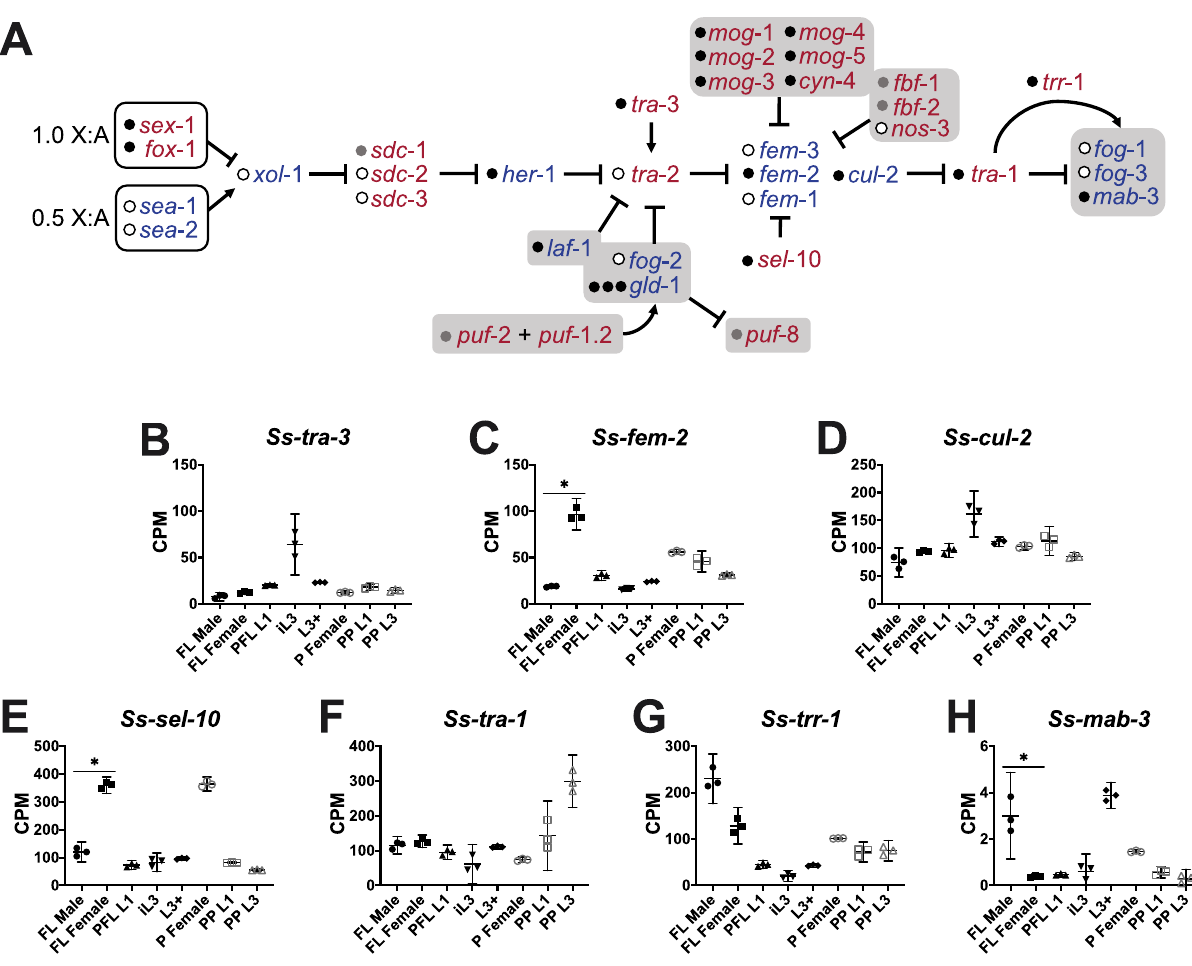
Figure 1. Components of the Caenorhabditis sex determination pathway are present in S. stercoralis , and key transcription factors likely have conserved function. ( A ) Genes that compose the “core” sex determination pathway in Caenorhabditis species, along with accessory genes that play a role in somatic (white boxes) and germline (gray boxes) sex determination, are diagrammed, with feminizing factors in red and masculinizing factors in blue. Homologs in S. stercoralis (black circle), homologs encoding a similar type of protein (gray circle), and genes for which no homolog was identified in the S. stercoralis genome (white circle), are indicated. Adapted from 26 . ( B – H ) Transcript abundances of the S. stercoralis homologs are represented using TMM- normalized counts per million (CPM) for the following developmental stages: free-living adult males (FL Male), free-living gravid adult females (FL Female), post-free-living first-stage larvae (PFL L1), developmentally arrested infectious third-stage larvae (iL3), L3 activated inside a permissive host (L3 +), parasitic gravid adult females (P Female), heterogonically-developing post-parasitic L1 (PP L1), and heterogonically-developing post- parasitic L3 enriched for females (PP L3). Graphs were constructed using GraphPad Prism v.9.0.0; bars indicate means (horizontal) and 95% confidence intervals (vertical) for each of the three biological replicates represented as individual data points. Asterisks (*) indicate a significant (fold change > 2.0; FDR < 0.05) difference between FL Male and FL